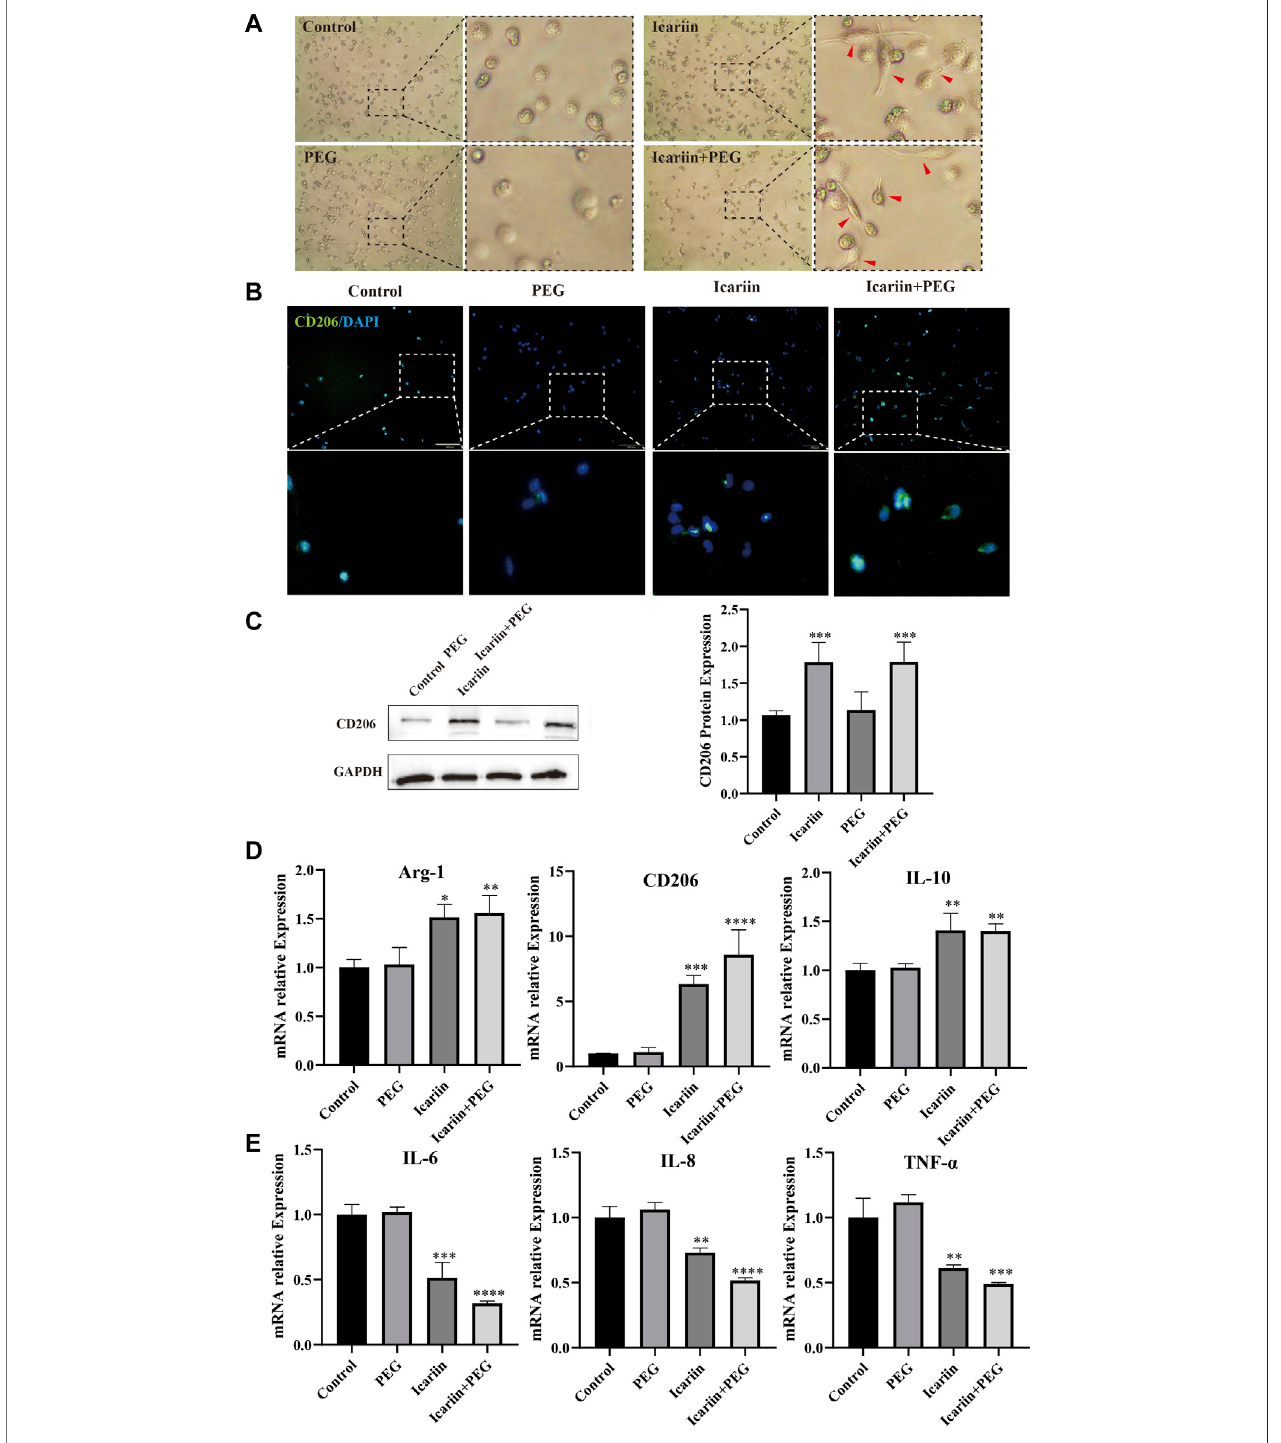
FIGURE6| Icariin+PEGhydrogelpromotedM2polarizationofmacrophagesandenhancedanti-in fl ammatoryeffects invitro . (A) MorphologicalchangesofTHP-1 macrophages after icariin treatment for 48 h were observed under an optical microscope. Red arrows indicate elongated macrophages. (B) Representative pictures of THP-1 immuno fl uorescencestainingwithCD206antibodyafterbeingco-culturedwiththehydrogelfor48 h.Scalebar:100 μ m;scalebarofmagni fi edpictures: 25 μ m. (C) Western blot analysis of the CD206 protein expression level in macrophages treated with different dressings for 48 h. Quanti fi cation of the western blotting bands compared to that of the control group. (D) RT-PCR analysis of M2-related gene ( ARG1 , CD206 , and IL-10 ) expression in macrophages. (E) RT-PCR analysis of M1-related gene ( IL-6 , IL-8 , and TNF- α ) expression in macrophages.